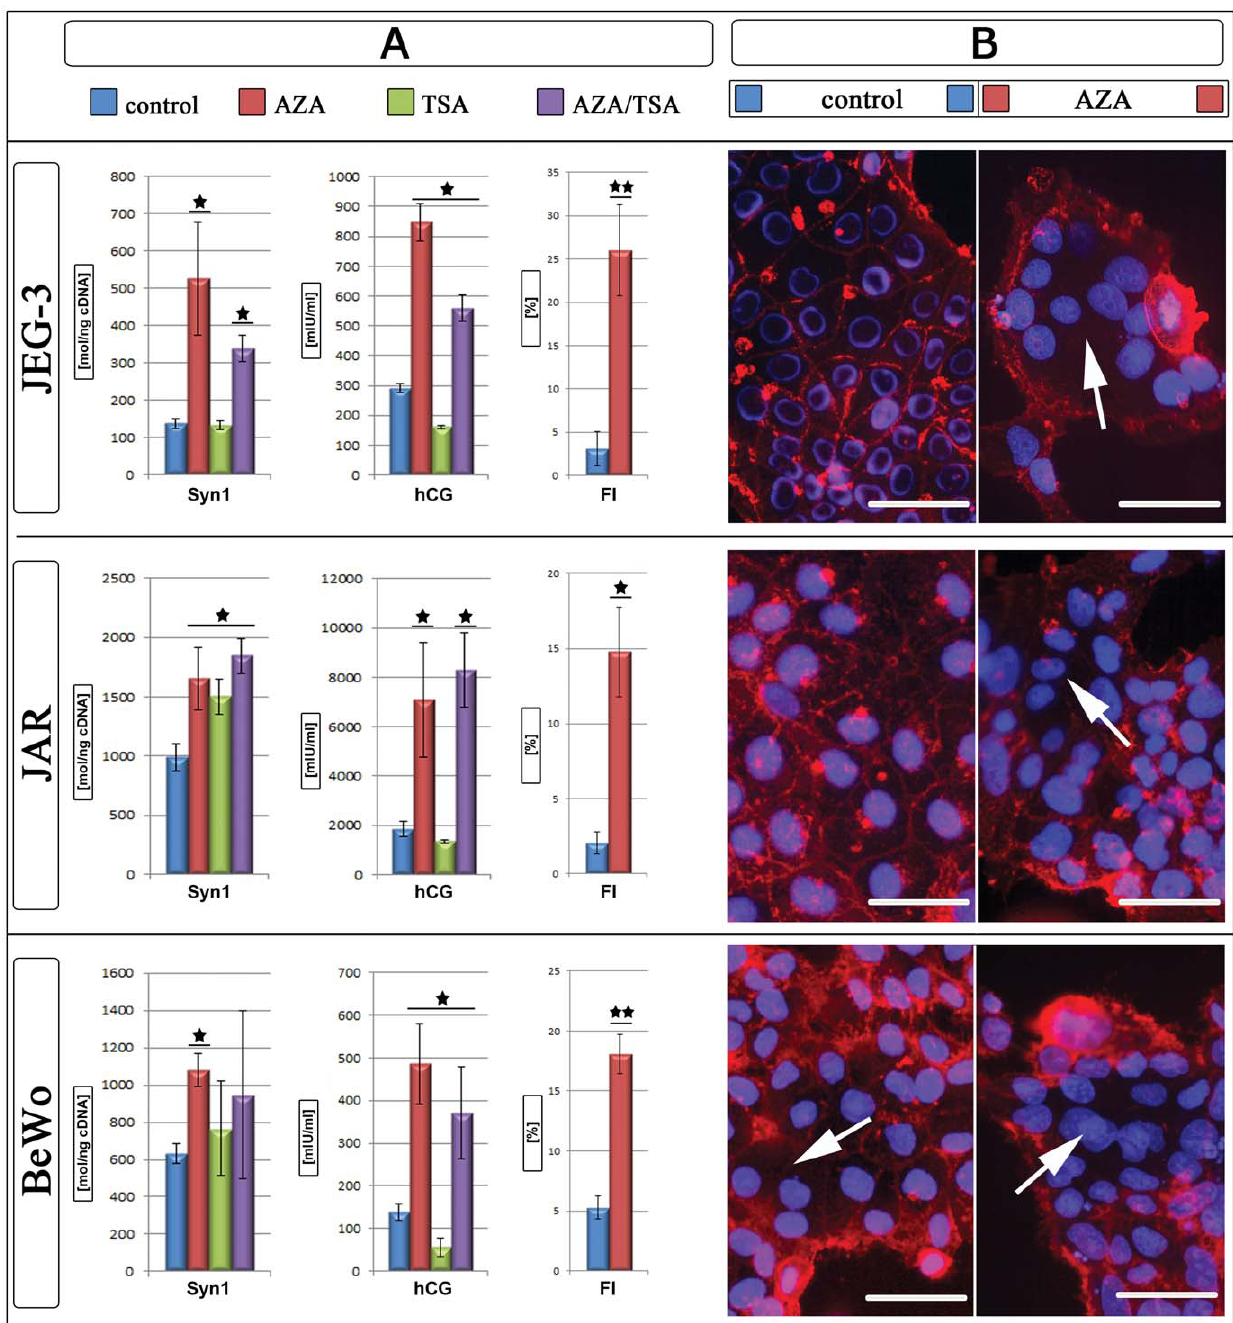
Figure 2. AZA and TSA treatment of trophoblast-like cell lines. A) Expression data of Syncytin-1 in molecules per ng cDNA [mol/ng cDNA ] and hCG [mlU/ml] for control (blue), AZA (red), TSA (green) and AZA/TSA (violet) treated cell lines and Fusion index [%] of control (blue) and AZA (red) treated cultures. B) For membrane stains of control (blue) and AZA (red) treated cell lines cell membranes were stained with wheat germ agglutinin Alexa594 (red) and nuclei with Hoechst 33342 (blue). White arrows mark syncytia. *P # 0.05; **P # 0.005; bars represent 50 m